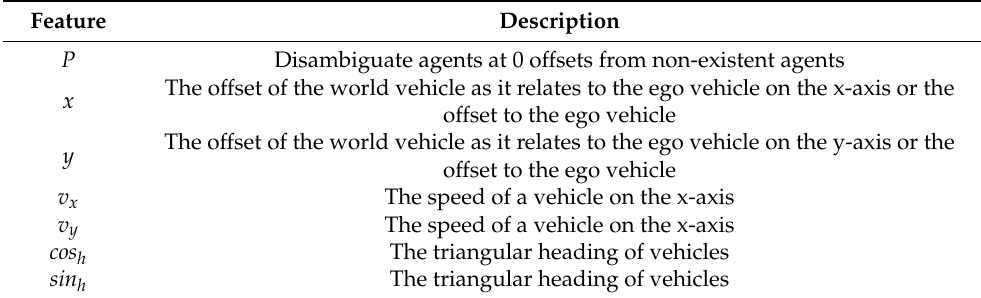
Table 2. The description of state space parameters.